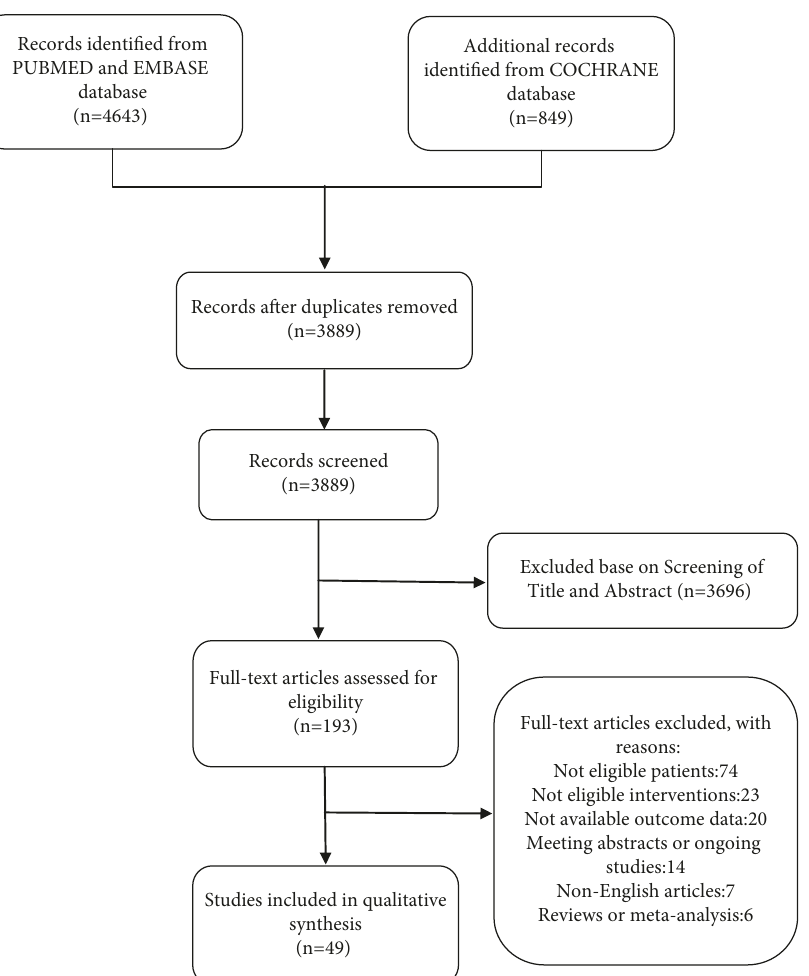
Figure 1: PRISMA diagram of the clinical review search